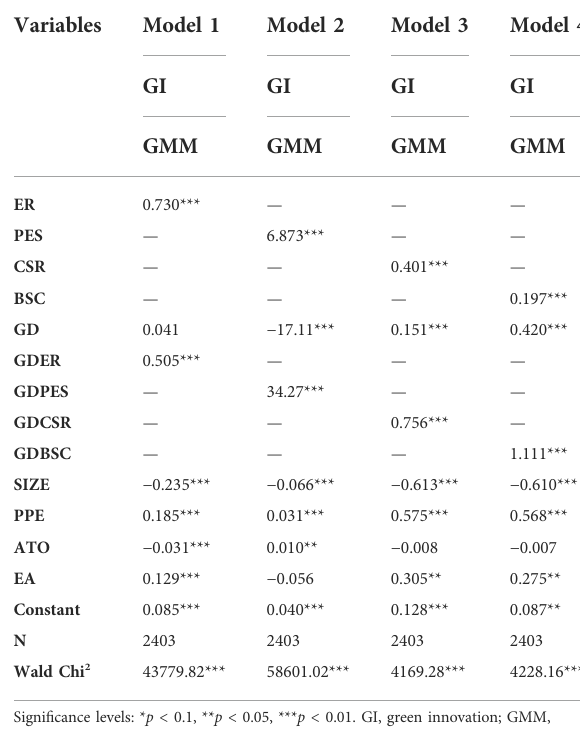
TABLE 5 Moderating role of